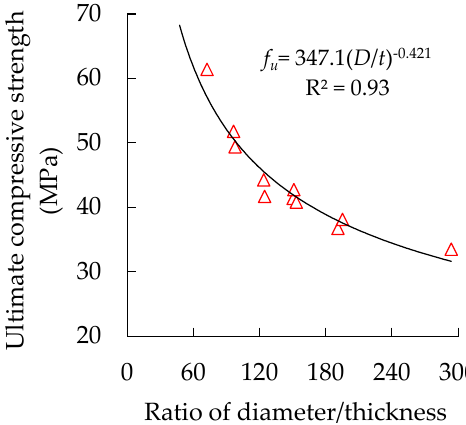
Figure 8. Relationship between specimens’ ultimate compressive strength and diameter/thickness ratios.